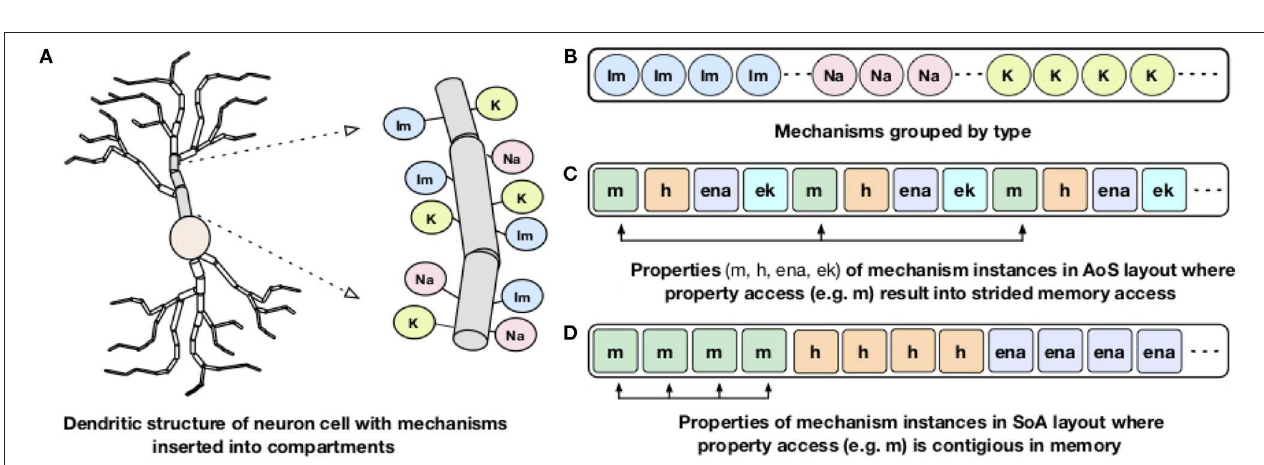
FIGURE 2 | Simulation workflow with the checkpoint-restart feature : CoreNEURON loads the model from disk, simulate it and dumps in-memory state back to disk ( SaveState step). CoreNEURON can load checkpoint data ( RestoreState step) and continue the simulation on a different machine using the checkpoint data. The user has flexibility to launch multiple simulations with different stimuli or random number streams ( Stim or RNG ) in order to explore network stability and robustness.